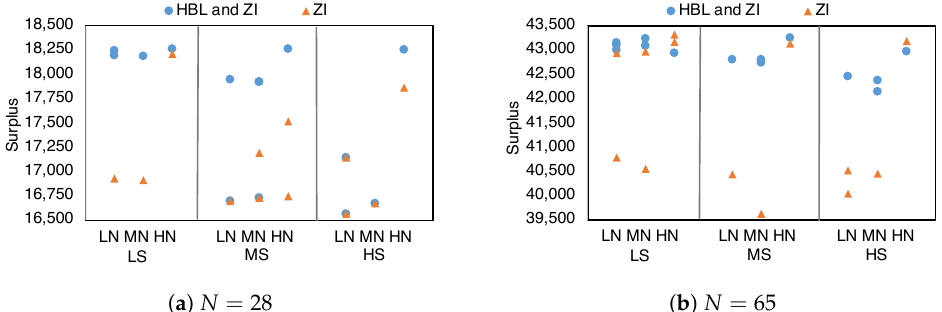
Figure 4. Comparisons of background-trader surplus for equilibria in each environment, with and without the HBL strategies available to background traders. Blue circles represent equilibrium outcomes when agents can choose both HBL and ZI strategies; orange triangles represent equilibrium outcomes when agents are restricted to ZI strategies. Overlapped markers are outcomes from the same equilibrium mixture, despite the availability of HBL. The market generally achieves higher surplus when HBL is available.